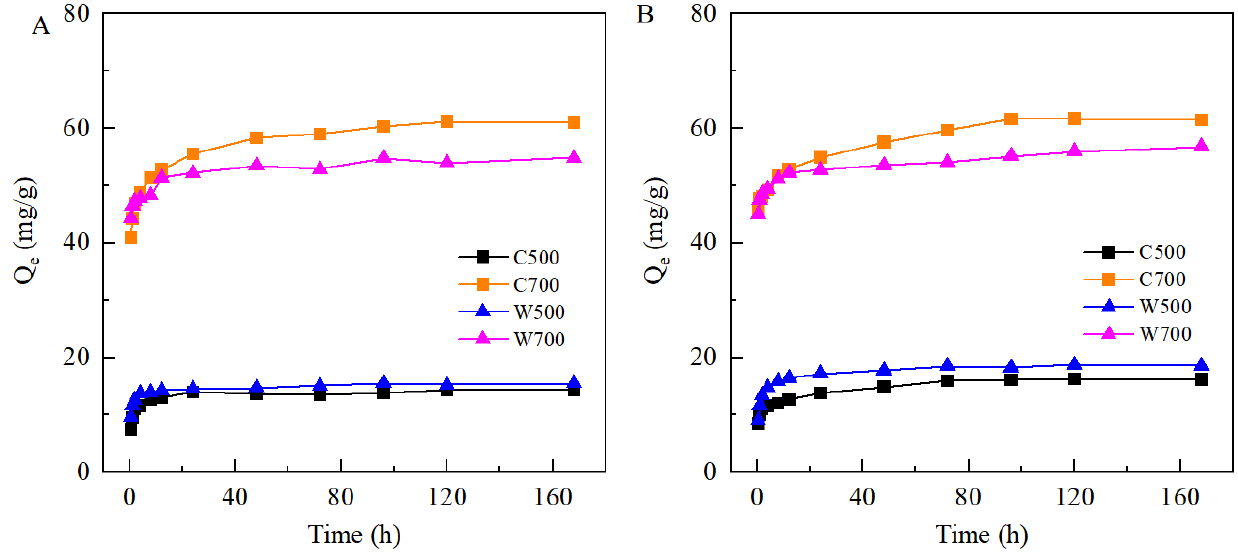
Figure 3. Effect of contact time on the adsorption of SMX ( A ) and TMP ( B ) (C 0 (SMX/ TMP) = 30 mg/L for the biochar prepared at 500 ◦ C and 60 mg/L for the biochar prepared at 700 ◦ C).